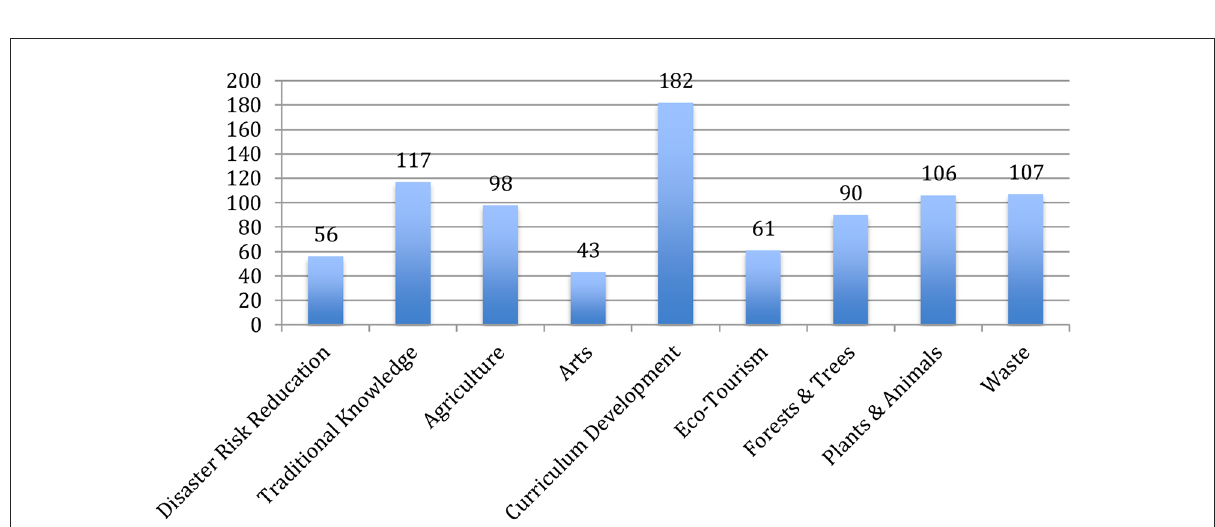
FIGURE12 RCE projects by theme during the GAP (2015–2019). n > 479, as RCEs were able to tag more than one theme if the RCE project incorporated more than one. For example, an RCE project worked with curriculum development may also have worked on incorporating traditional knowledge into curriculum, and the project would have two tags for this